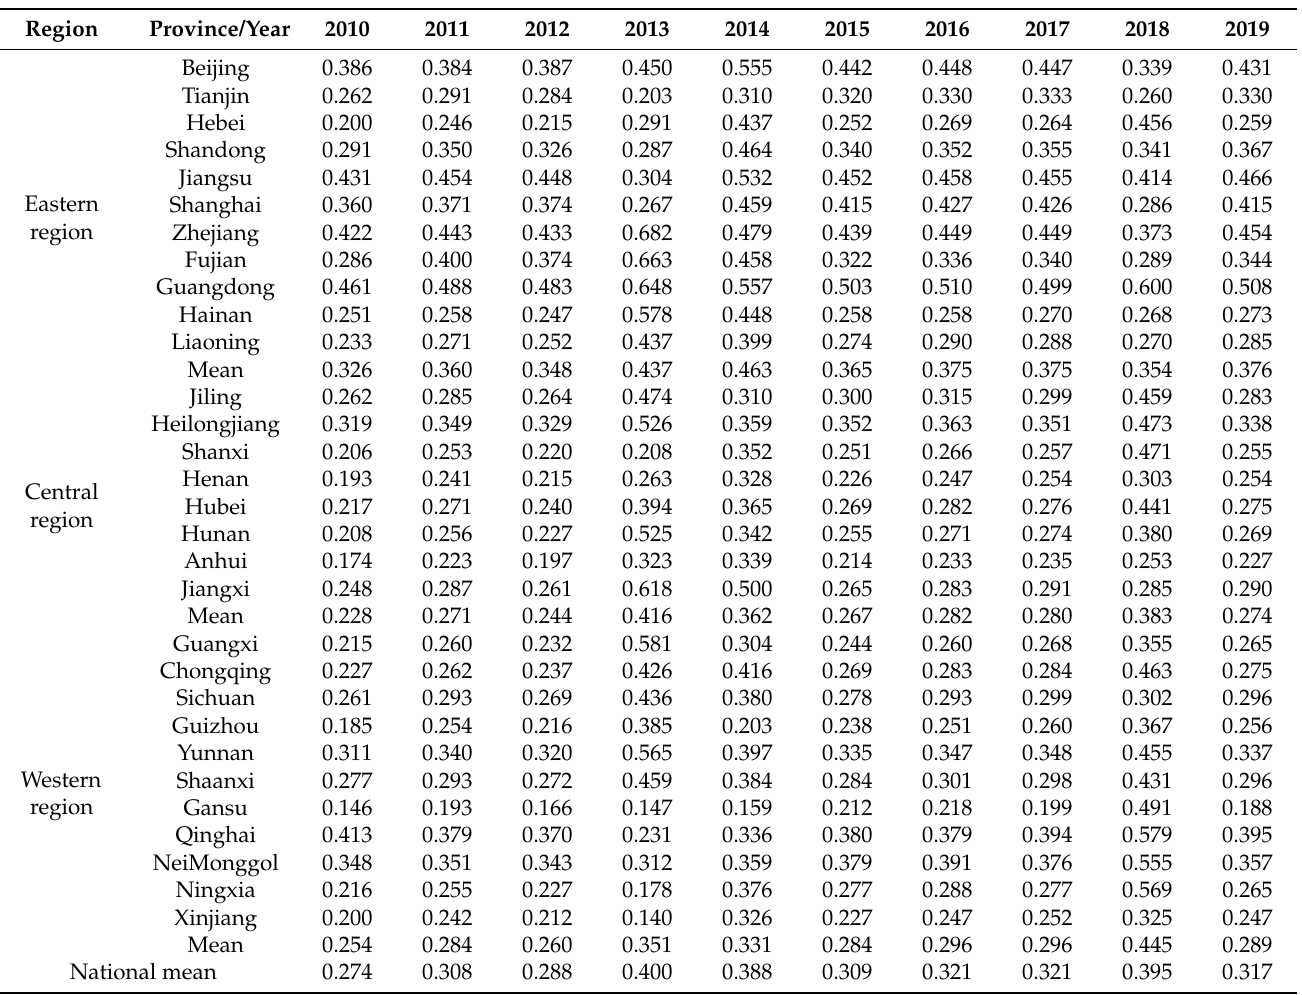
Table 2. Green development level in China from 2010 to